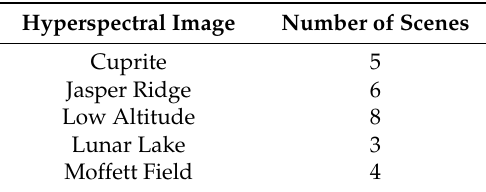
Table 1. Description of the Dataset 1.